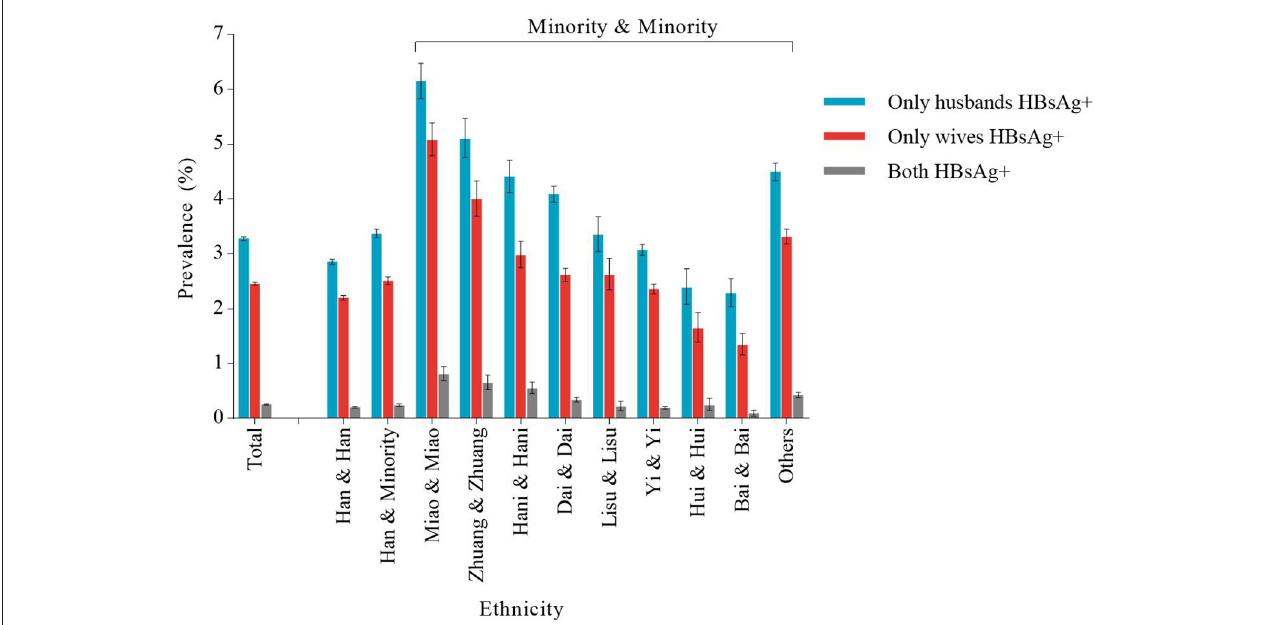
FIGURE 1 | Ethnic disparities in hepatitis B surface antigen (HBsAg) status in reproductive-age